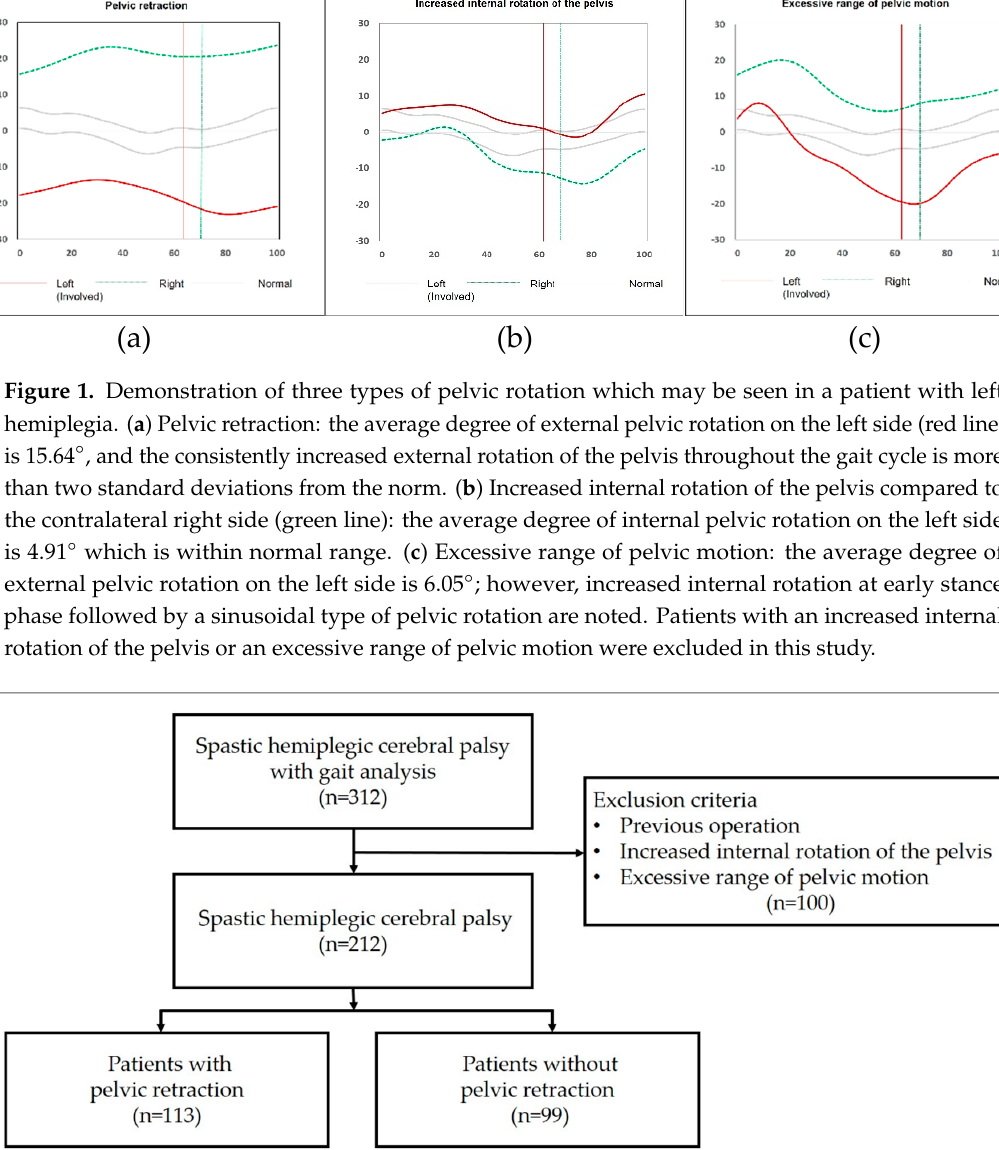
Figure 2. Flow diagram of inclusion and exclusion criteria in the study.